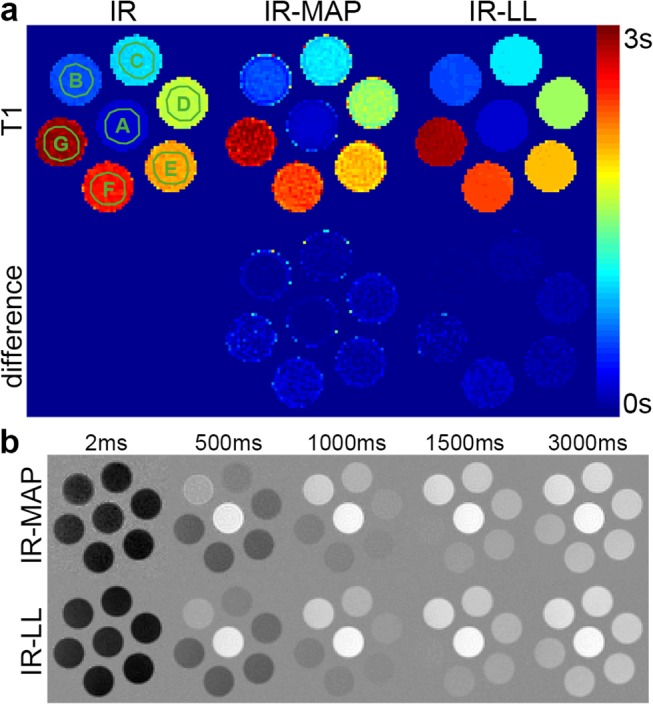
Phantom measurement.a: T1 maps of the segmented IR reconstruction (left), the IR-MAP reconstruction of the single-inversion IR-LL acquisition (center) and the segmented IR-LL reference (right) and the differences (bottom). b: Reference IR-LL images and IR-MAP reconstructions for exemplary inversion times.